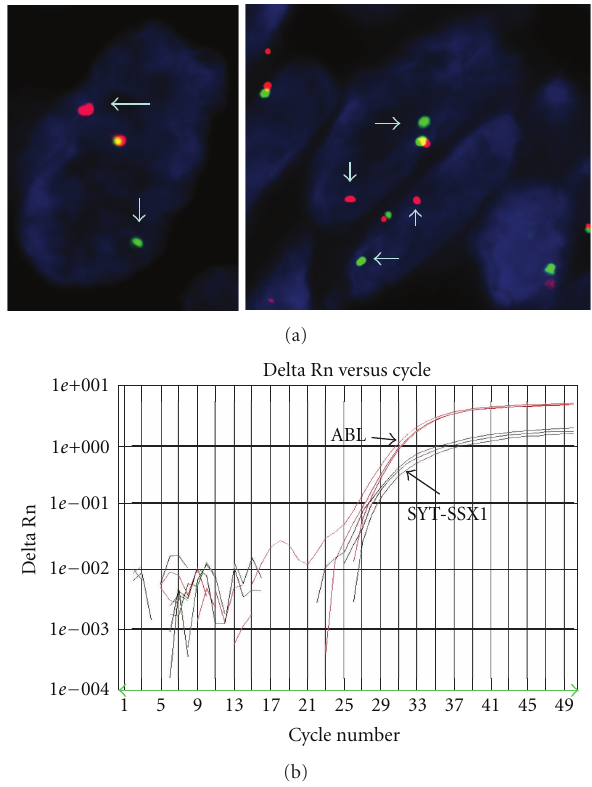
Figure 4: (a) Fluorescent in situ hybridization (FISH) contained mixture of probe-labeled SYT gene. The arrows showed break apart of the gene indicating translocation. (b) Real-time PCR (RT-PCR) revealed the amplification of SYT-SSX1 gene (black); ABL gene (red) was used as internal control.